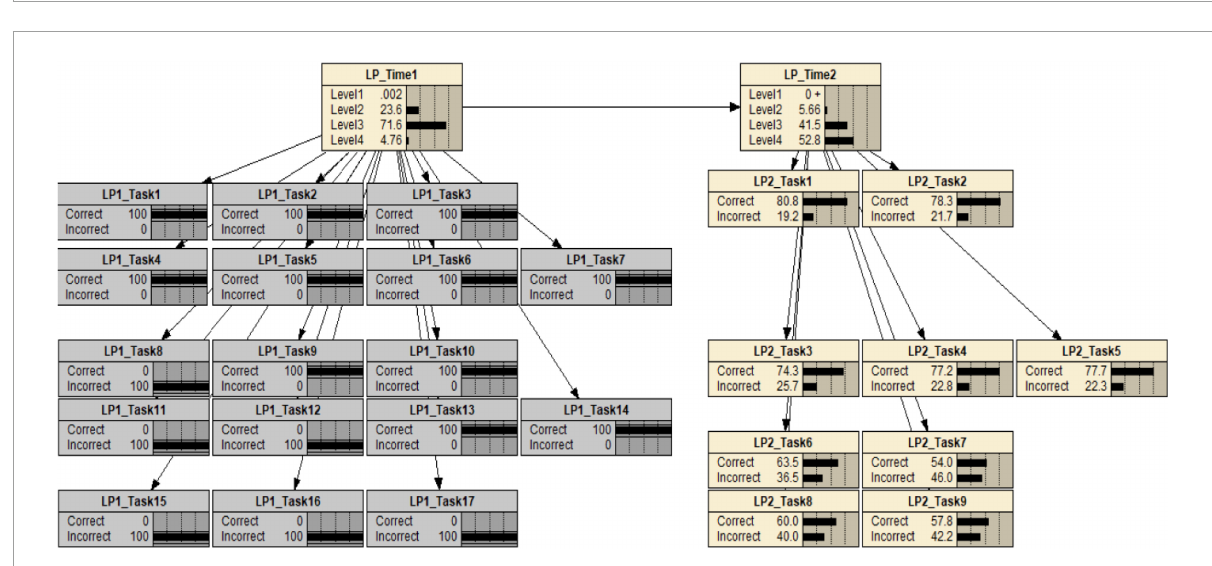
FIGURE9 A DBN for a student who has completed 17 tasks at the first